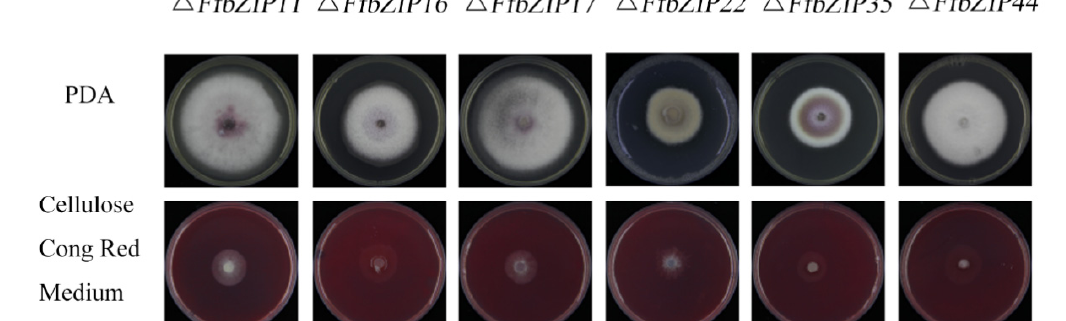
Figure 8. Cellulose utilization experiment. ( A ) Growth of wild type and FfbZIP knockout mutants in Cellulose Congo red medium. ( B ) Histogram of strain diameter under cellulose Congo red culture conditions. Error bars represent means ± SEs. * p < 0.05, ** p < 0.01. 2.6.6. Cellophane Penetration Experiment To clarify the ability of the deletion mutants to penetrate the plant cell wall, cello- phane was used to simulate the plant cell wall. Δ FfbZIP2 , Δ FfbZIP4 , Δ FfbZIP5 , Δ FfbZIP16 , Δ FfbZIP44 and wild type grew through cellophane, indicating their ability to penetrate plant cell walls, while Δ FfbZIP8 , Δ FfbZIP10 , Δ FfbZIP11 , Δ FfbZIP17 , Δ FfbZIP22 and Δ Ff- bZIP35 could not (Figure 9). The results revealed that FfbZIP8 , FfbZIP10 , FfbZIP11 , FfbZIP17 , FfbZIP22 , and FfbZIP35 played a decisive role in the penetration of F. fujikuroi infection into plant cell walls, while FfbZIP2 , FfbZIP4 , FfbZIP5 , FfbZIP16 , and FfbZIP44 did not.